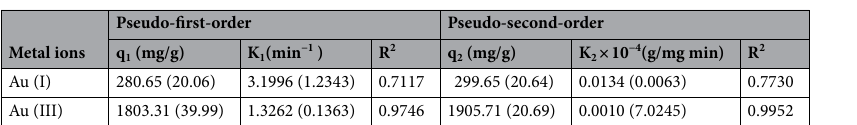
Table 1. Comparison of the kinetic parameters for the adsorption of Au (I) and Au (III) onto PEIIAC.